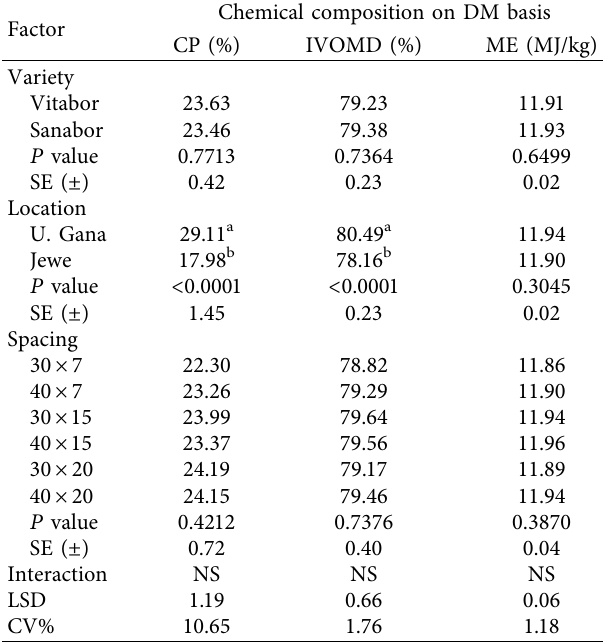
Table 7: Effects of location, variety, and spacing on crude protein, IVOMD and metabolizable energy content of sweet lupine seed.